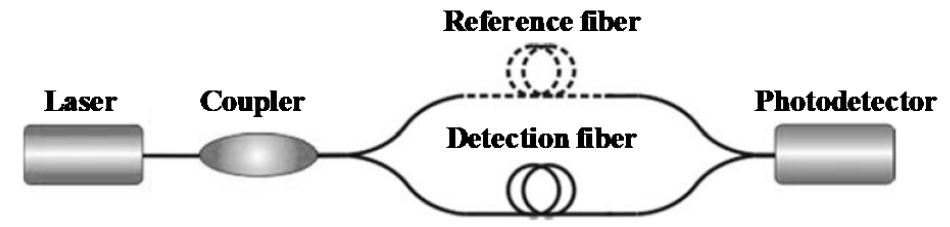
Figure 14. Schematic of the MZI.